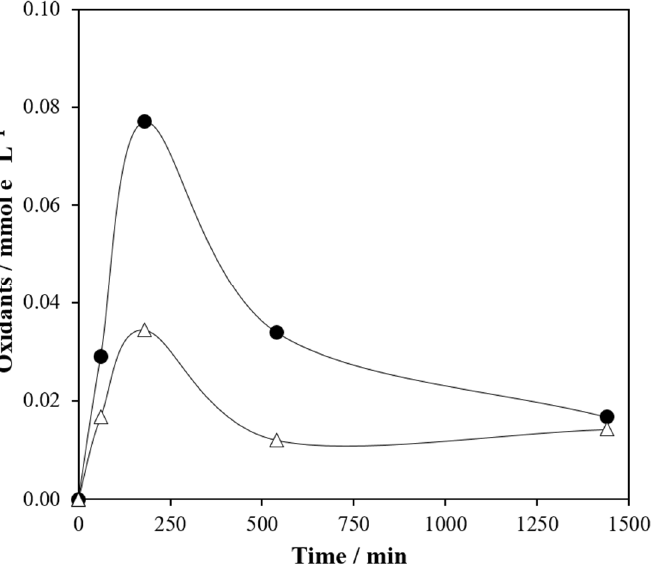
Figure 8. Oxidation capacity of the gases produced from in the chlorine dioxide reactor. ( • ) Test EQI, ( ∆ ) test EQII.